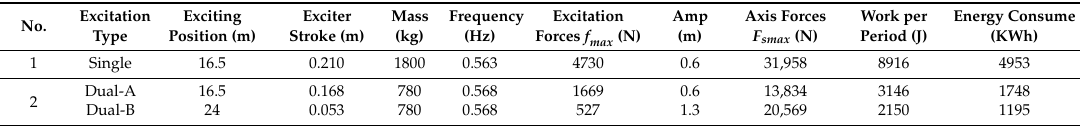
Table 3. Performance parameters of single- and dual-point